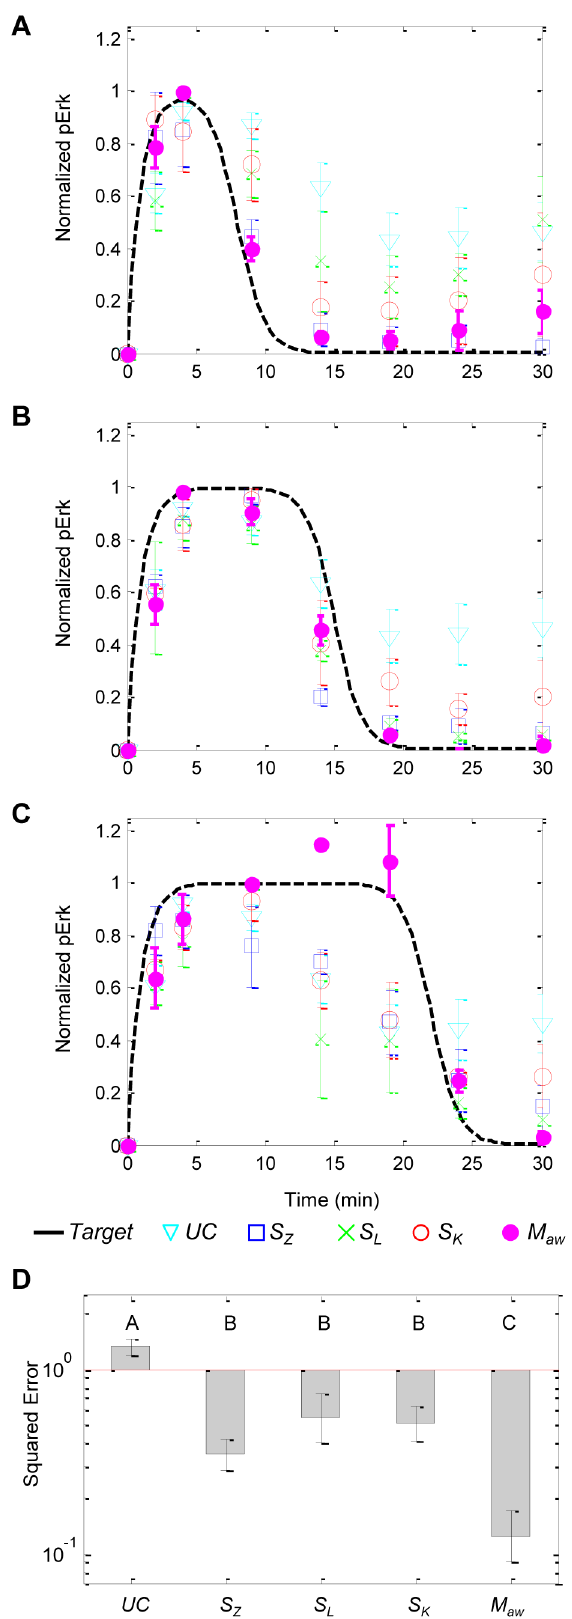
Figure 6. Overall invitro target tracking performances between target profiles and measured Erk phosphorylation. Experiments with target trajectories (solid black) defined by the ( t off , p ss ) pairs of ( A ) (8,0), ( B ) (15,0) and ( C ) (22,0). Data are measurements of plant dynamics that were uncontrolled ( UC , cyan triangle, n=12) and controlled by S Z (blue square, n=9), S L (green x, n=9), S K (red circle, n=9) and M aw (magenta dot, n=9). Data shown are mean 6 standard error. ( D ) Controller performances as measured by squared error between target trajectories and controlled plant dynamics. Group letters denote statistically significant differences between groups (p , 0.05) as calcu- lated by one-way ANOVA with Tukey multiple comparisons test (SigmaStat v3.5, Systat Software,